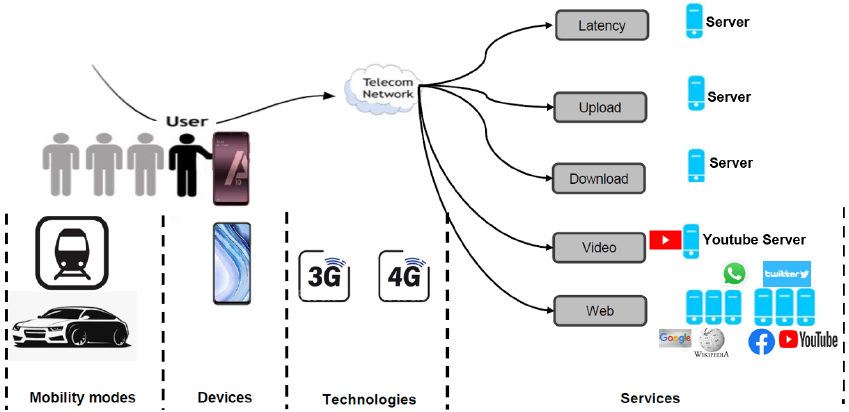
Figure 1. Overview of the crowdsourcing campaign